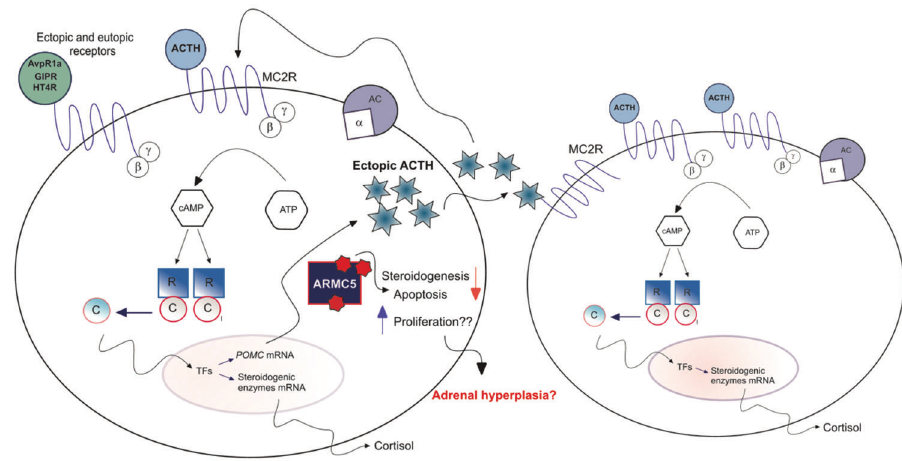
Figure 1 - Steroidogenesis in adrenocortical cells is regulated by the binding of ACTH to MC2R, activating PKA pathway through the release of the catalytic subunit (C) by the action of cAMP in specific domains of the PKA, followed by the phosphorylation of transcrip- tion factors (TFs) in the nucleus that will increase the transcription of steroidogenic enzymes, leading to cortisol production. In addition to this classic signaling, PMAH cells can be abnormally regulated by aberrant receptors that mimic the action of ACTH when activating PKA; additionally, the activation of PKA regulates the production of ectopic ACTH within the hyperplastic nodules that will once again activate PKA independently of pituitary ACTH, allowing a certain independency to cell steroidogenesis. Additionally, mutations in ARMC5 are the main molecular events associated with PBMAH; ARMC5 decreases steroidogeneis, induces cell apoptosis and might also be involved in cell proliferation by mechanisms so far